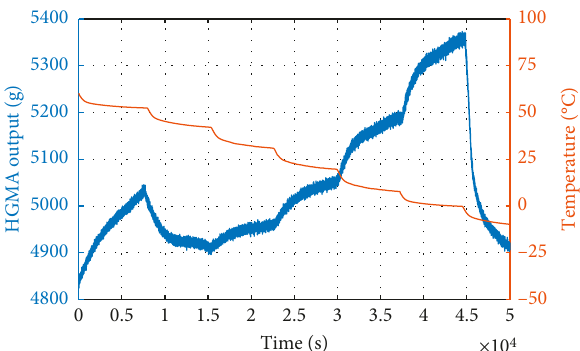
Figure 9: MEMS accelerometer output in the temperature experiment.